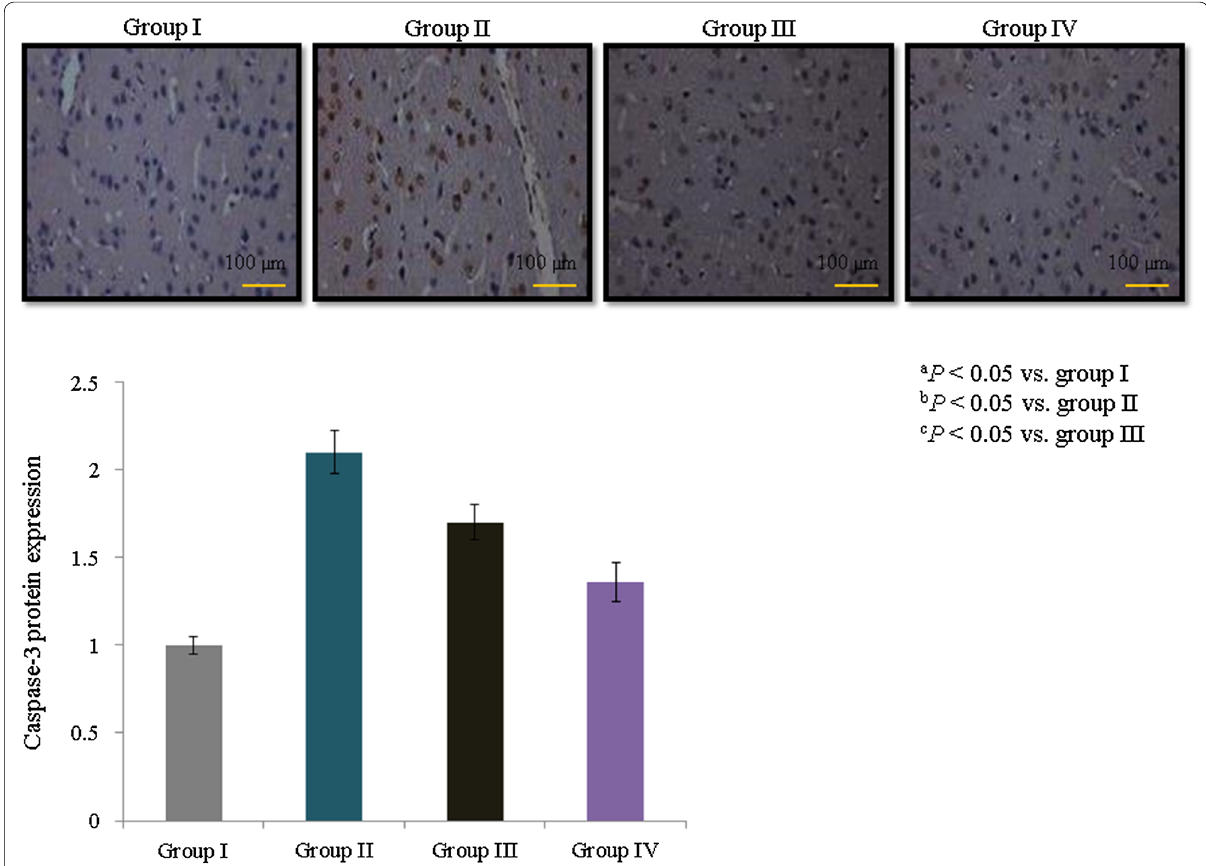
Fig. 6 Effect of E. hirta extract on caspase-3 protein expression in neonatal asthmatic rats. Experimental data are given as the mean